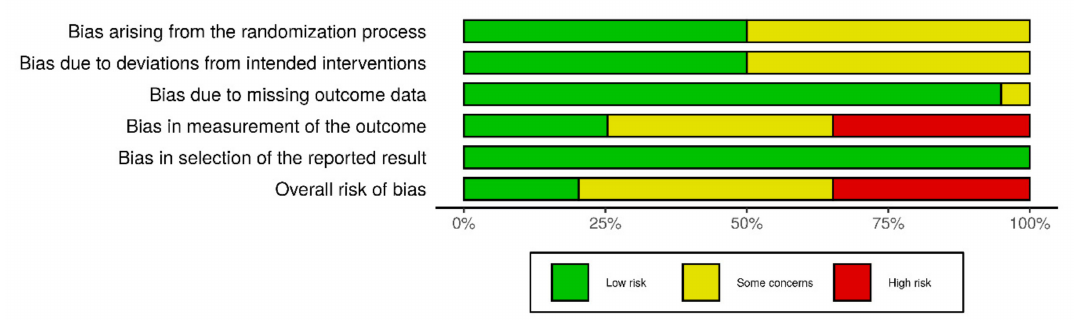
Figure A1. Risk of bias weighted summary plot: review authors’ judgements about each risk of bias item presented as percentages across all included randomized controlled trial (RCT) studies.